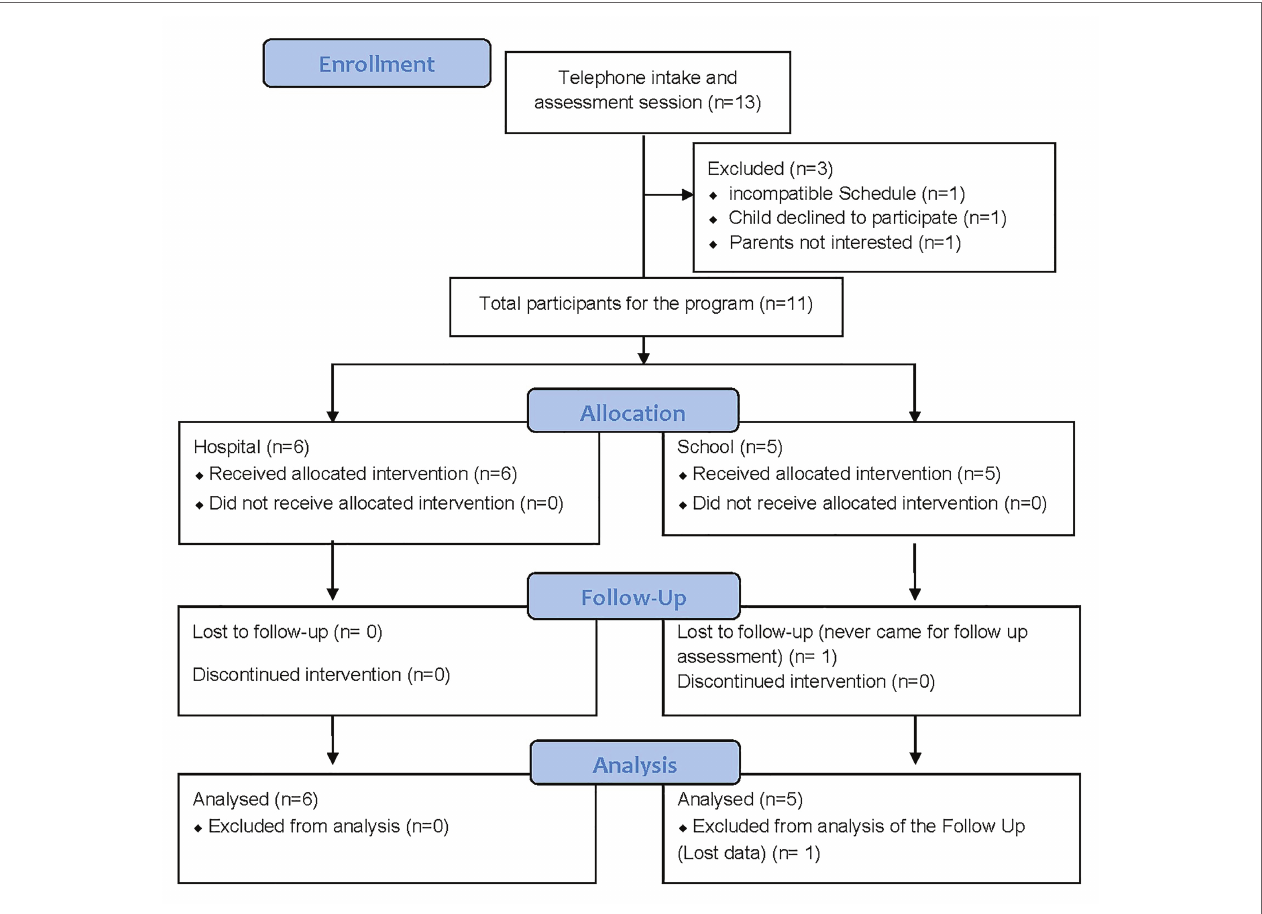
FIGURE 1 | CONSORT flow chart of